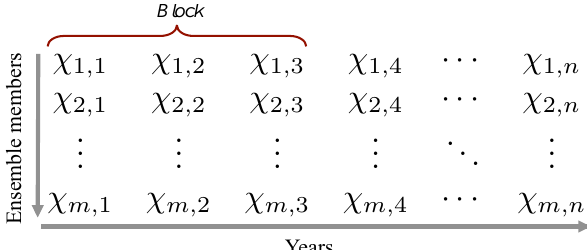
Figure 1. Schematic of the general reconstruction method using an offline approach. Prior ensembles of m state vectors, χ , are assigned to each of the n years. To retain some temporal coherency, the rows are composed of time-coherent blocks drawn from a climate model simulation (arbitrarily illustrated here as a 3-year block, or three consecutive annual states). The method updates prior ensembles for specific years corresponding to annual proxy data points, while for long-timescale proxies prior ensembles are computed by time av- eraging across the rows corresponding to the years of a proxy data